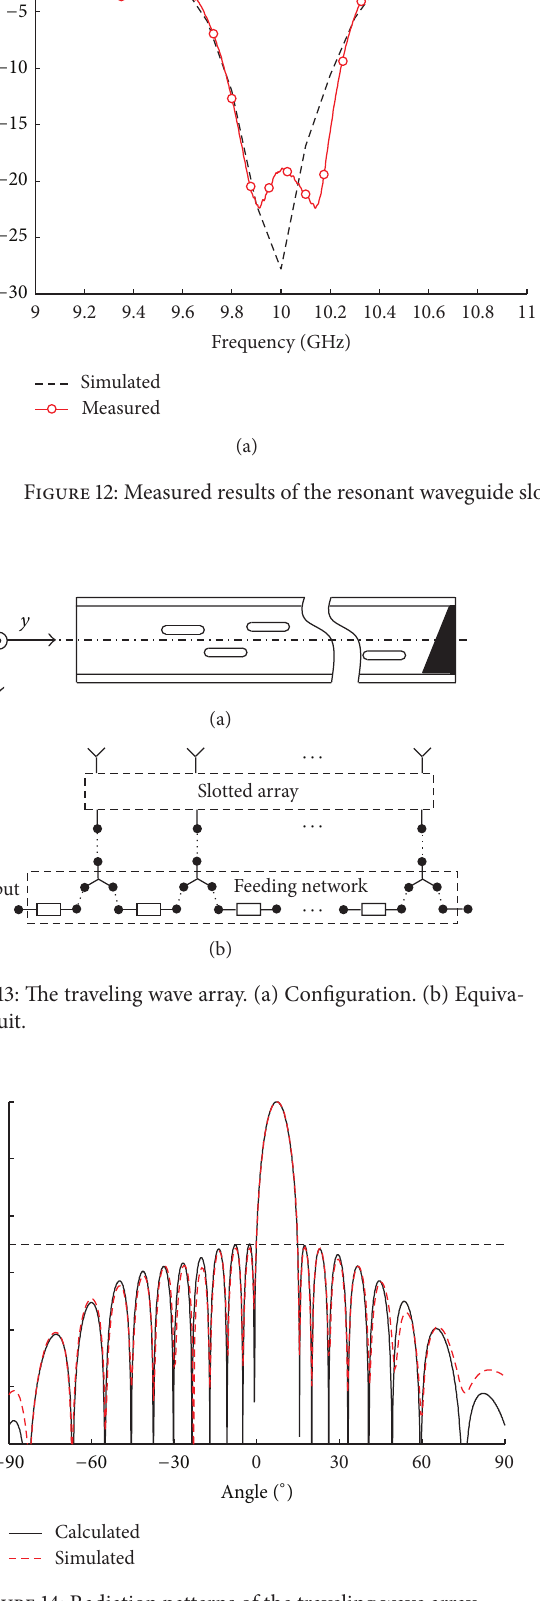
Figure 14: Radiation patterns of the traveling wave array.